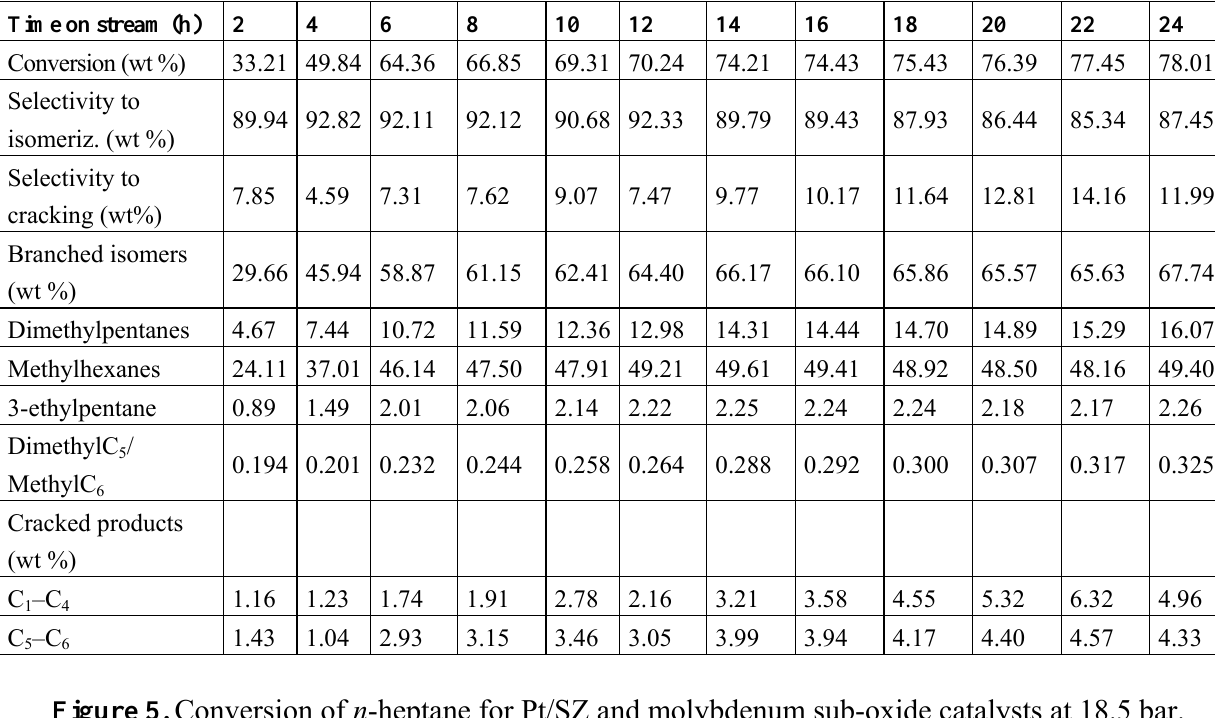
Figure 5. Conversion of n -heptane for Pt/SZ and molybdenum sub-oxide catalysts at 18.5